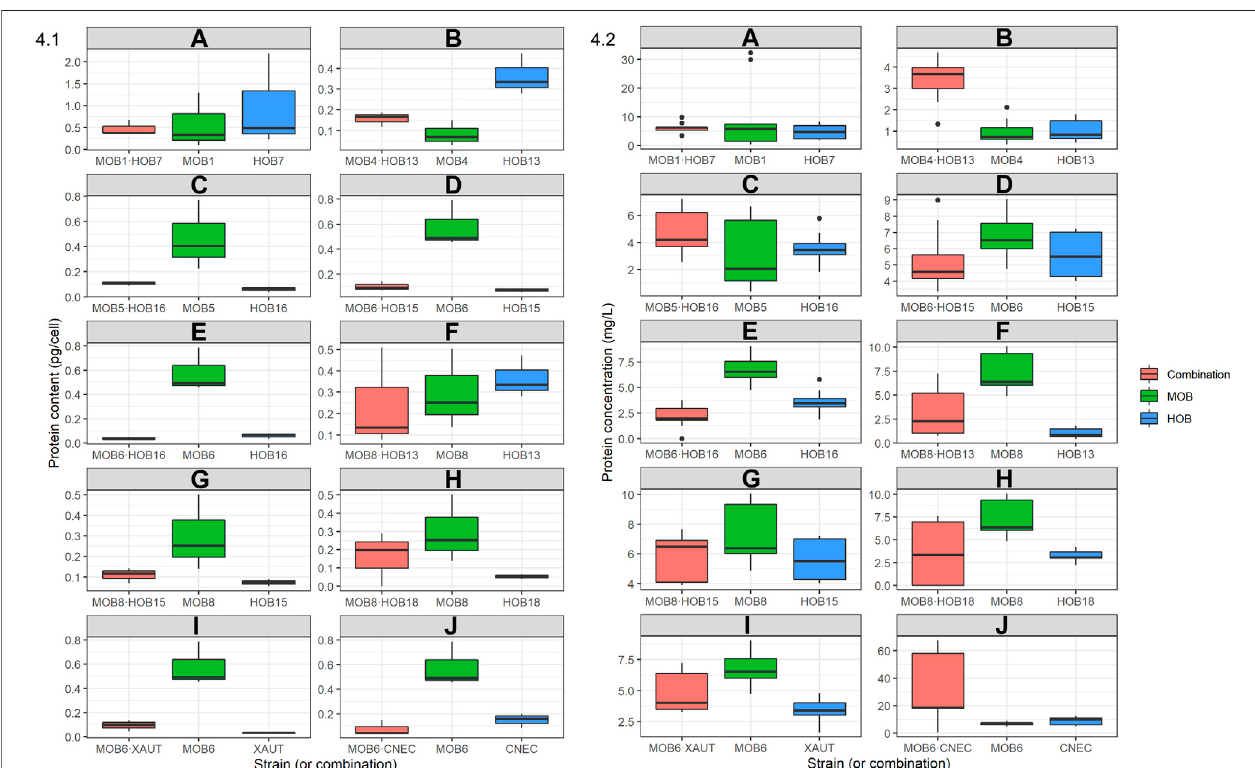
FIGURE4| Box-and-whiskerplotsof4.1proteincontent(pg/cell)and4.2proteinconcentration(mg/L)oftheindividualHOBandMOBculturesaswellasselected combinations as determined after 5 days of growth. The protein concentration was quanti fi ed using the BioRad DC protein assay with bovine serum albumin (BSA) as standard. Outliers are shown with black dots outside of the box-and-whisker plots, the median is shown as a horizontal black bar inside of the plots. Axes between subplots are not constant. The complete dataset is presented in Supplementary Tables S4, S5